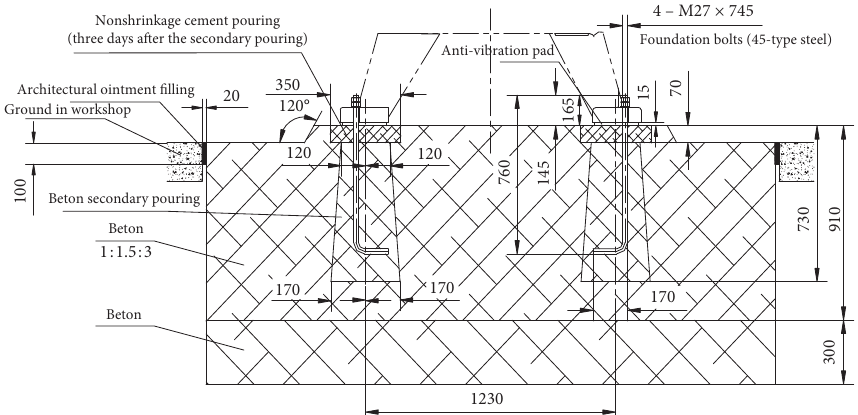
Figure 5: Foundation of punching press.